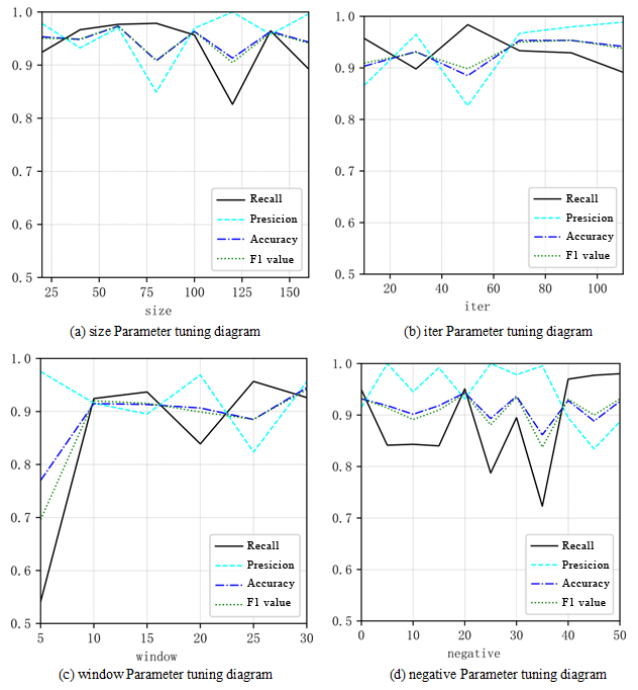
Figure 4. Word2Vec parameter tuning relationship diagram for LSTM.